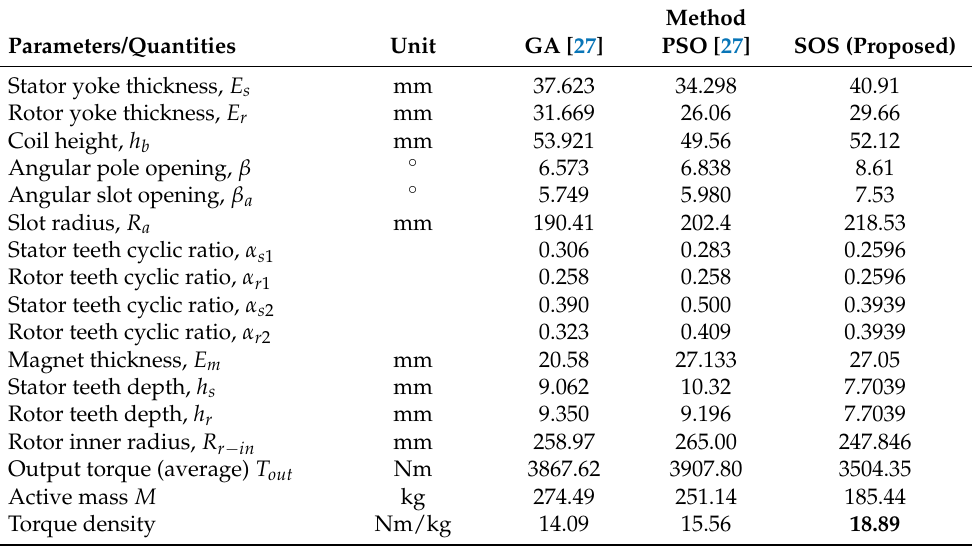
Table 3. Final search variable and quantities of importance values found through SOS optimization, along with comparison with other